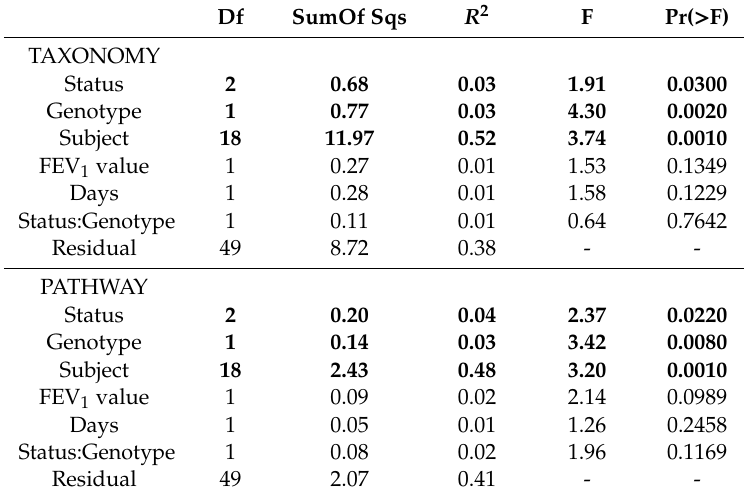
Table 2. Permutational multivariate analysis of variance on both taxonomic distribution and metabolic pathways. Df SumOf Sqs R 2 F Pr( >